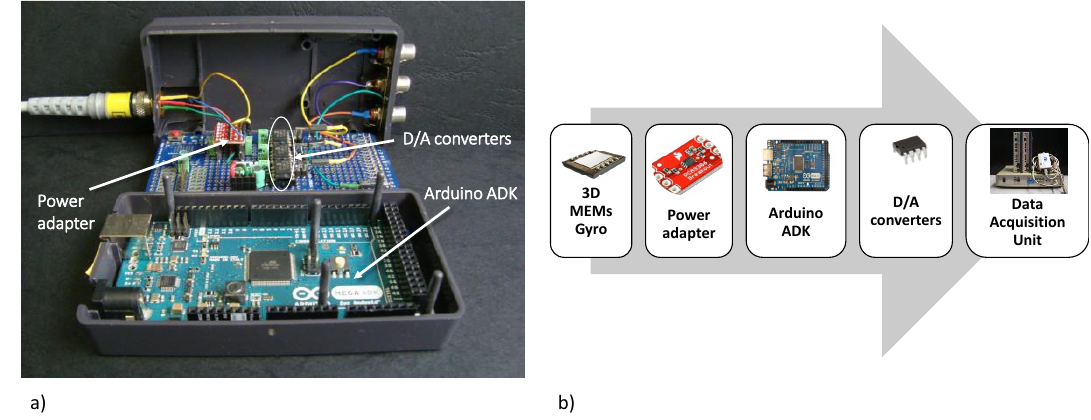
Figure 3. ( a ) Picture and block diagram of ( b ) the data reading unit developed for the output reading of the 3D gyro included in the CardioMon lead.